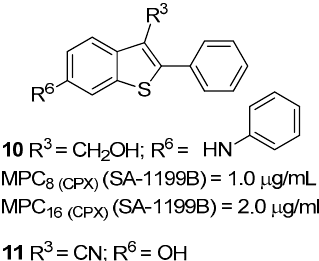
Figure 4. Benzothiophene derivatives as NorA EPIs.